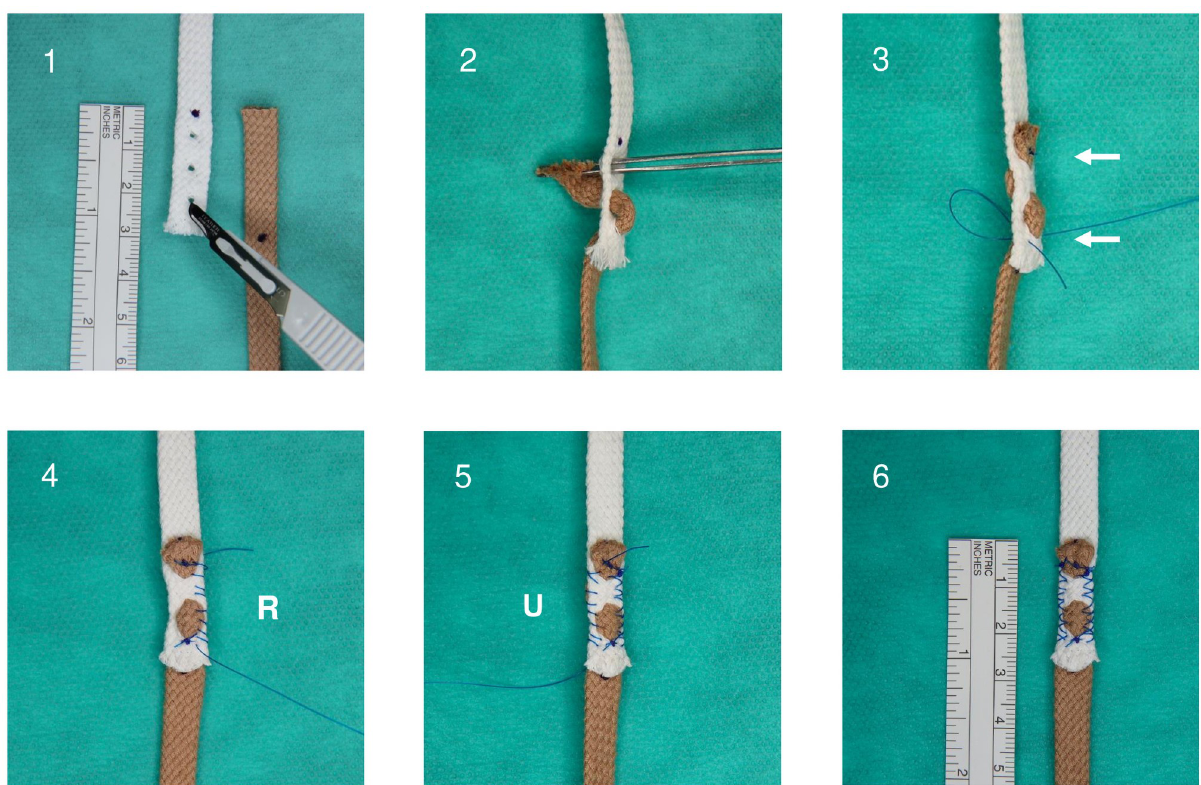
Fig 2. Schematic model of the Woven-Fride´n tenorrhaphy (WF) (30 mm tendon-tendon overlap) using brown and white strings. 1. Mark incisions and overlap for donor- (brown) and recipient tendon (white) with a surgical pen and make three incisions in the recipient tendon using a No. 15 scalpel blade. 2. Interlace the donor tendon (brown) through the recipient tendon (white). 3. Perform two double-loop sutures at proximal and distal end of tenorrhaphy (arrows). 4. Perform eight running cross stitches at the radial side (R) and 5. ulnar side (U) of the tenorrhaphy. 6. WF tenorrhaphy (the overlap has been reduced to approximately 27 mm due to interlacing of